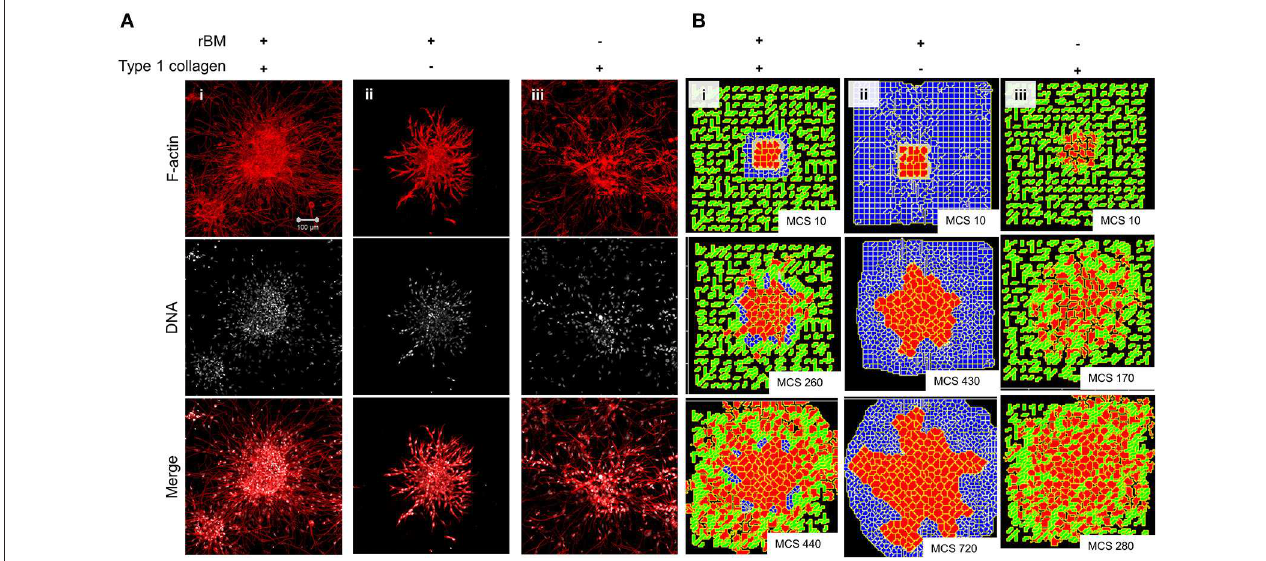
FIGURE 3 | Single-matrix controls of models show simpler modes of invasion. (A) Maximum intensity projections of laser confocal micrographs of MDA-MB-231 cell clusters cultured within specific matrix milieu, fixed and stained for F-actin (using phalloidin; red; top row), DNA (using DAPI; white; middle row), and with both signals merged (bottom row). (i) rBM-coated clusters embedded in type 1 collagen show multiscale invasion (left column). (ii) rBM-coated clusters embedded in rBM show collective or streaming migration of cells, (iii) Uncoated MDA-MB-231 clusters in type 1 collagen show predominantly single cell invasion. Scale bar: 100 µ m. (B) Representative images from simulations of invasion of cancer cells at early (top row), intermediate (middle row), and late MCS steps (bottom row). Simulations mimicking cells encapsulated within nonfibrillar and then fibrillar ECM exhibit multiscale invasion (left column). Simulations of cells cultured exclusively in nonfibrillar and fibrillar ECM show collective and single cell migration ( Bii and Biii ). Interfibrillar gap of C1 = 3 unit pixels.